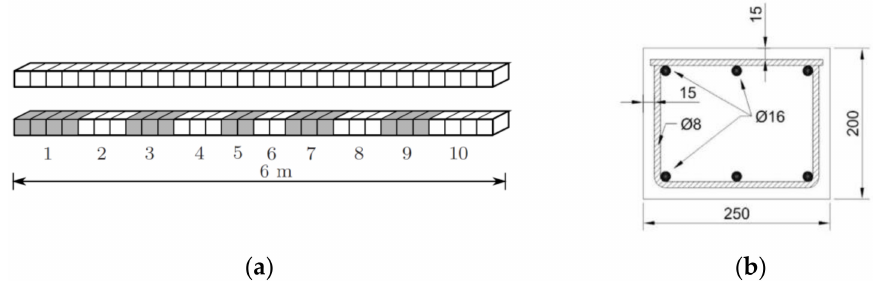
Figure 11. ( a ) Sketch of an reinforced concrete (RC) beam showing 10 sub-elements with 10 different bending stiffness; ( b ) the cross section of the RC beam [4].